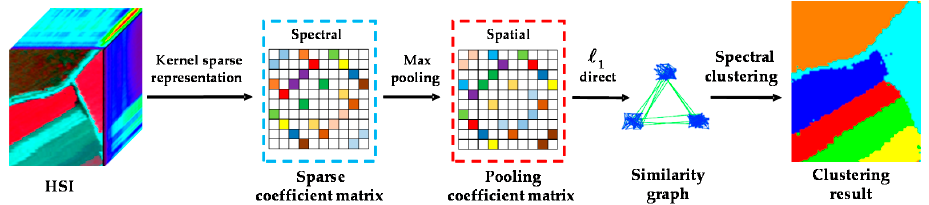
Figure 2. The flowchart of the proposed kernel sparse subspace clustering algorithm with a spatial max pooling operation (KSSC-SMP) algorithm. Firstly, the kernel sparse representation model is adopted to more precisely represent each target pixel by exploiting the inherent nonlinearity of hyperspectral images (HSIs). The spatial max pooling operation is then introduced to yield new features with these coefficients by incorporating the spatial-contextual information. Next, the similarity graph is constructed in the (cid:96) 1 -direct way. Lastly, by applying the spectral clustering algorithm to the similarity graph, the final clustering result can be obtained.